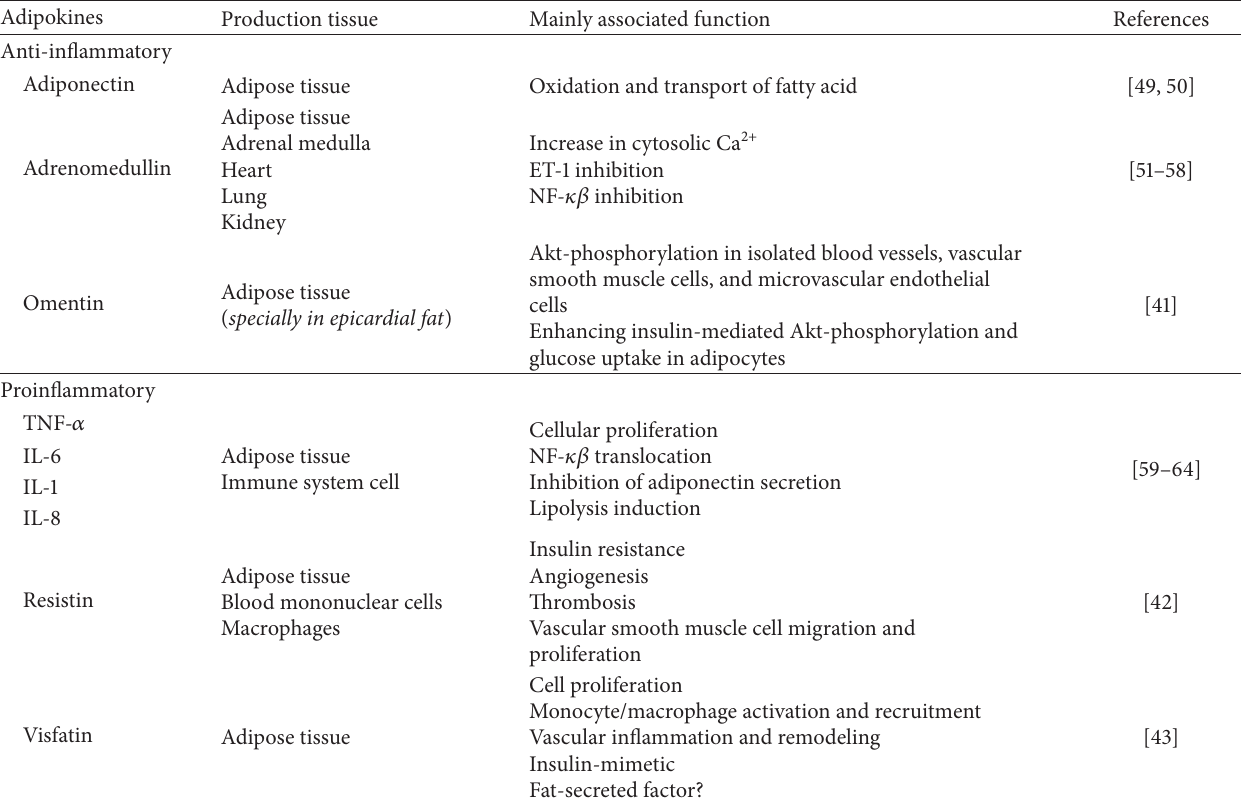
Table 1: Main adipokines release by EAT and other